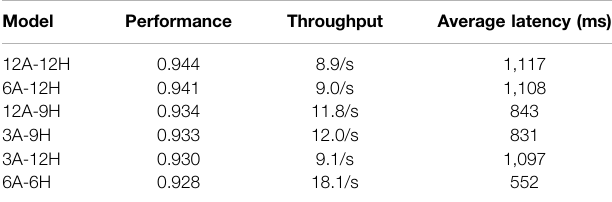
TABLE 5 | Benchmark of intent classi fi cation API performance across different models in real-time application. Each model is tested using 10 threads, simulating 10 concurrent users, for a duration of 10 min. In this test, models are notservedasMonteCarlosampling,sotheinferenceisdoneonlyonce.Allmodels arehostedonidenticalAWSm5.4xlargeCPUinstances.Asseen,thesimplest model (6A-6H, six attention layers and six hidden layers) can have a double throughput rate and half latency than the original BERT small model, and the accuracy performance only drops 1.6%. The performance is evaluated using JMeter at theclientside,andAPIs areserved using Domino Lab3.6.17 Model API. Throughput indicates how many API responses being made per second. Latency is measured as time elapse between request sent till response received at client